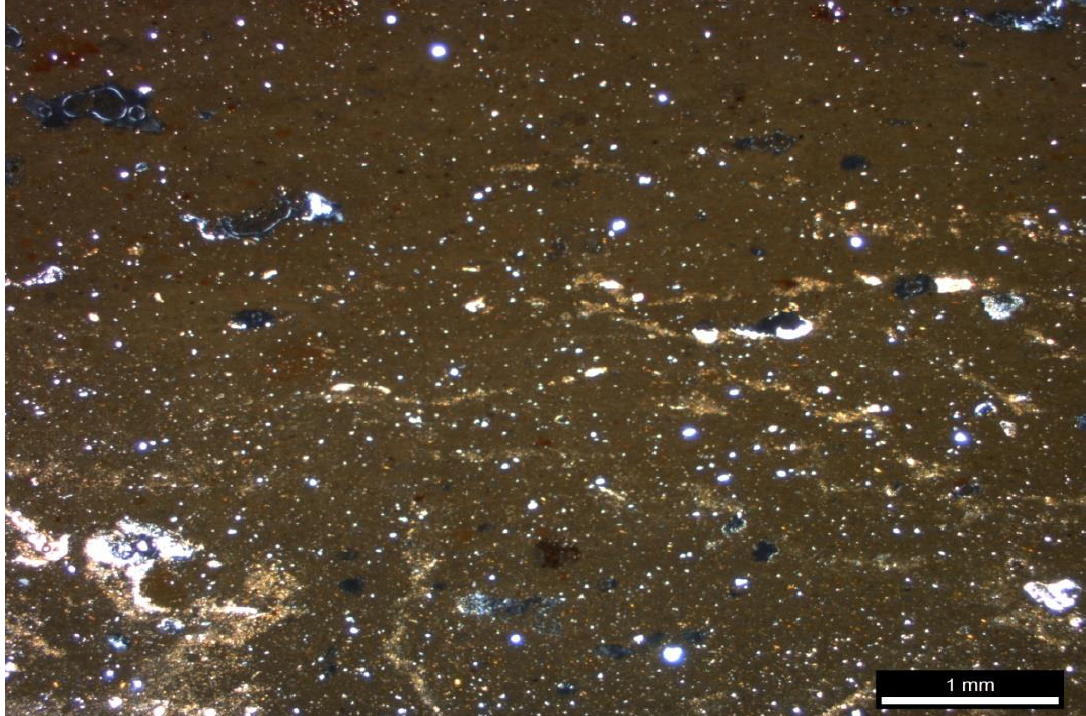
Figure 16. Photomicrograph of fabric SAR 11 under crossed-polars, demonstrating post-depositional alteration of carbonate matter observed as micritic patches and striations within groundmass (ELF 12/14). Image by William Gilstrap.